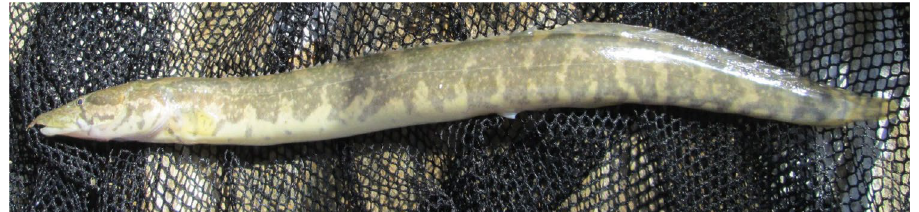
Figure 1. A sample of M. mastacembelus caught during the study (original photo).